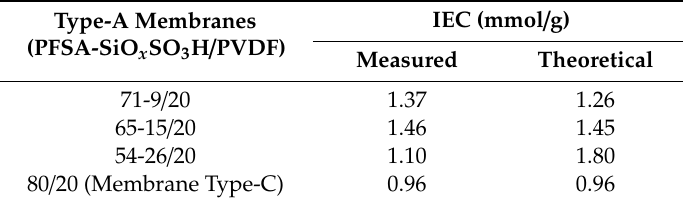
Table 3. Hybrid Type-A nanofiber composite membrane properties with varying levels of inorganic sulfonated silica network in PFSA, where all of the membranes contained 20 wt.% PVDF